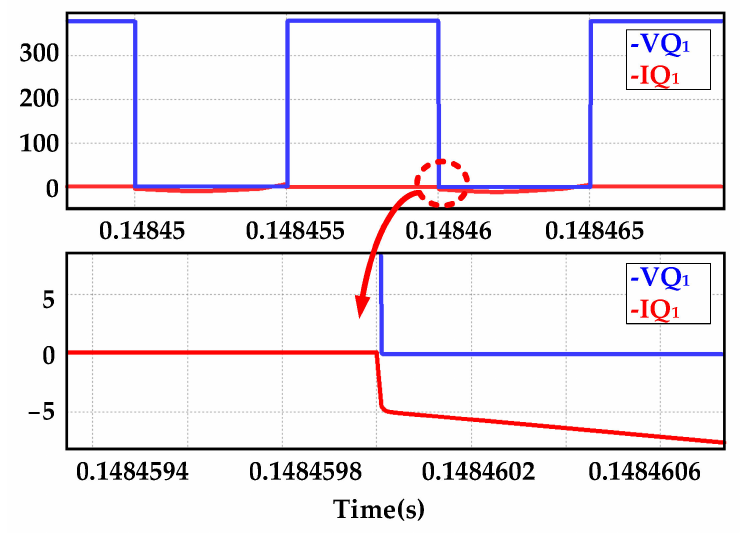
Figure 15. Current waveform and voltage waveform of Q 1 in the optimized